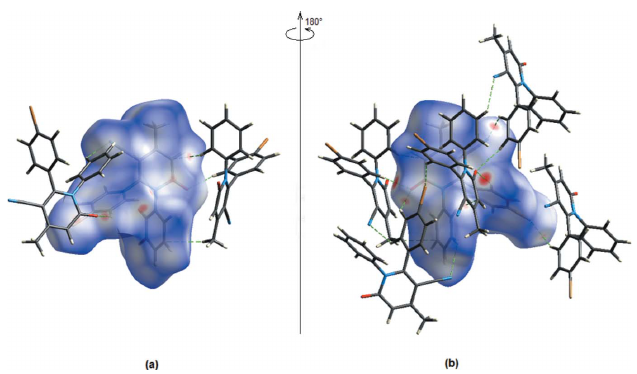
Figure 6 ( a ) Front and ( b ) back sides of the three-dimensional Hirshfeld surface of